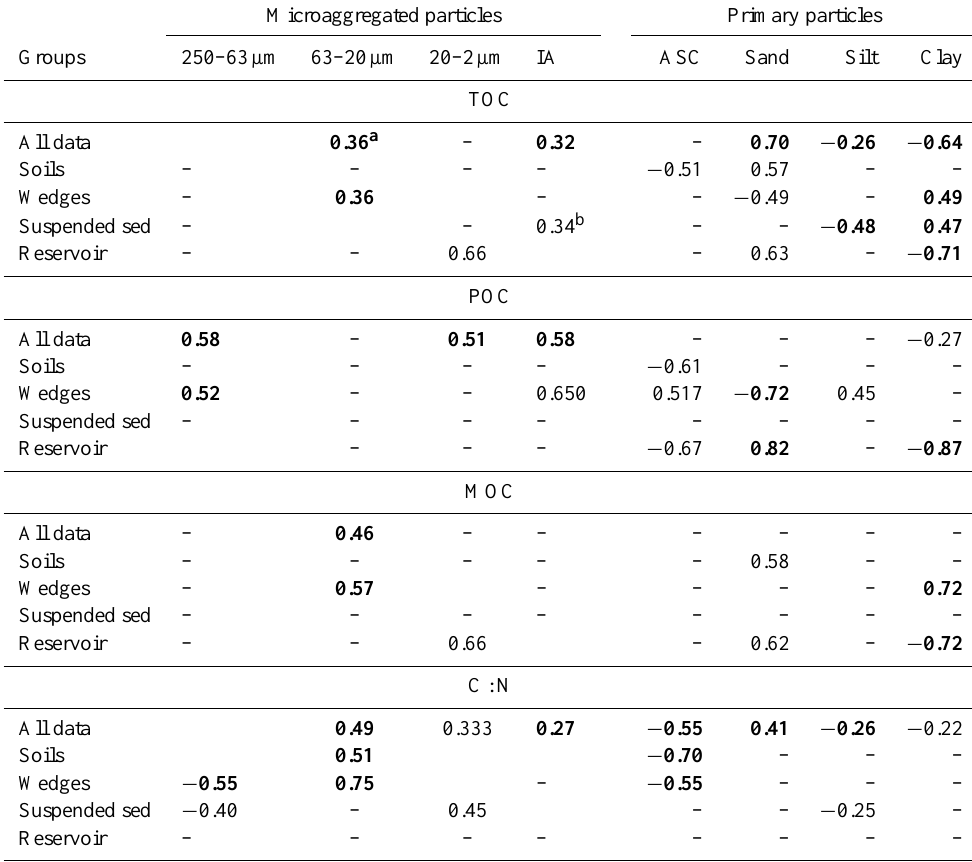
Table 3. Spearman correlation coefficients between primary and microaggregated particle indicators and organic carbon pools and C:N